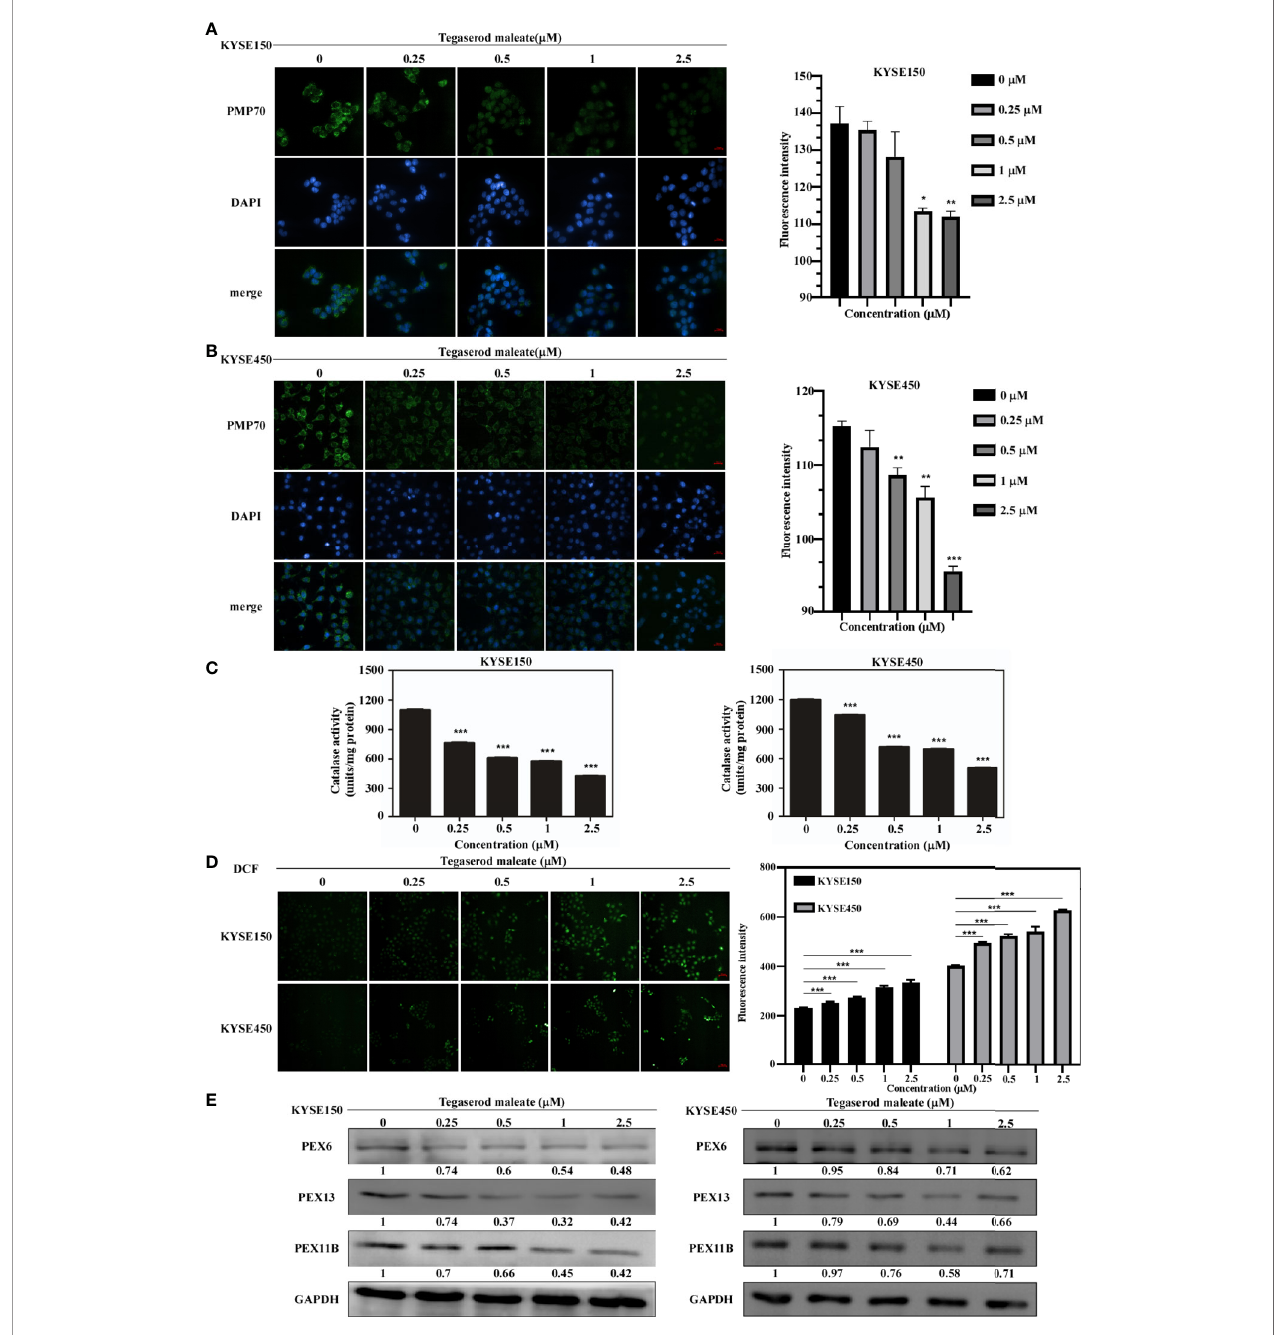
FIGURE 3 | Tegaserod maleate inhibits the peroxisome function in ESCC cells by PEX6, PEX11B, and PEX13. Immuno fl uorescence results showed the downregulation of PMP70 in KYSE150 cells (A) and KYSE450 cells (B) . Left panel: the representative pictures of fl uorescence (scale, 20 m m). Right panel: the statistics of fl uorescence intensity. Data is shown with mean ± SD. (* p < 0.05, ** p < 0.01, *** p < 0.001 vs . untreated control, n = 4). (C) With increasing concentration of tegaserod maleate (0, 0.25, 0.5, 1.0 and 2.5 m M), the catalase activity is decreased in KYSE150 cells and KYSE450 cells. (D) Dose-dependent effects of tegaserod maleate on cellular ROS levels of KYSE150 cells and KYSE450 cells, respectively. Left panel: representative pictures of fl uorescence (scale, 60 m m). Right panel: statistics of fl uorescence intensity. Data is shown with mean ± SD. (* p < 0.05, ** p < 0.01, *** p < 0.001 vs . untreated control, n = 10). (E) Western blotting shows that the levels of PEX6, PEX11B and PEX13 are decreased after treatment with tegaserod